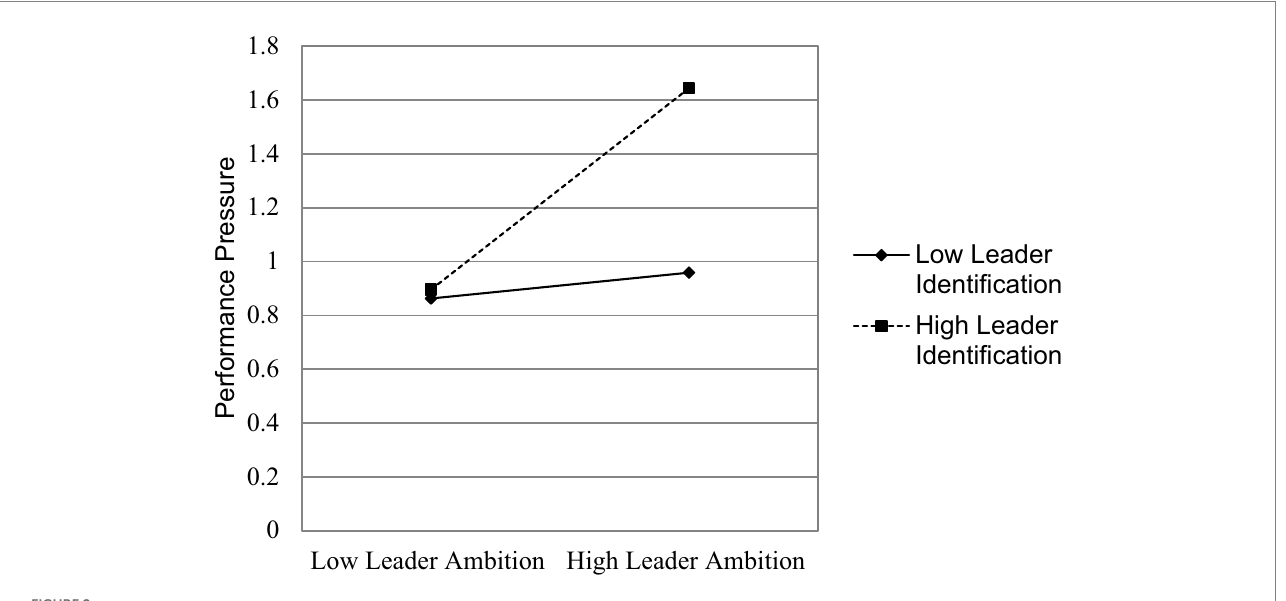
FIGURE 2 Study 1: interaction of leader ambition and leader